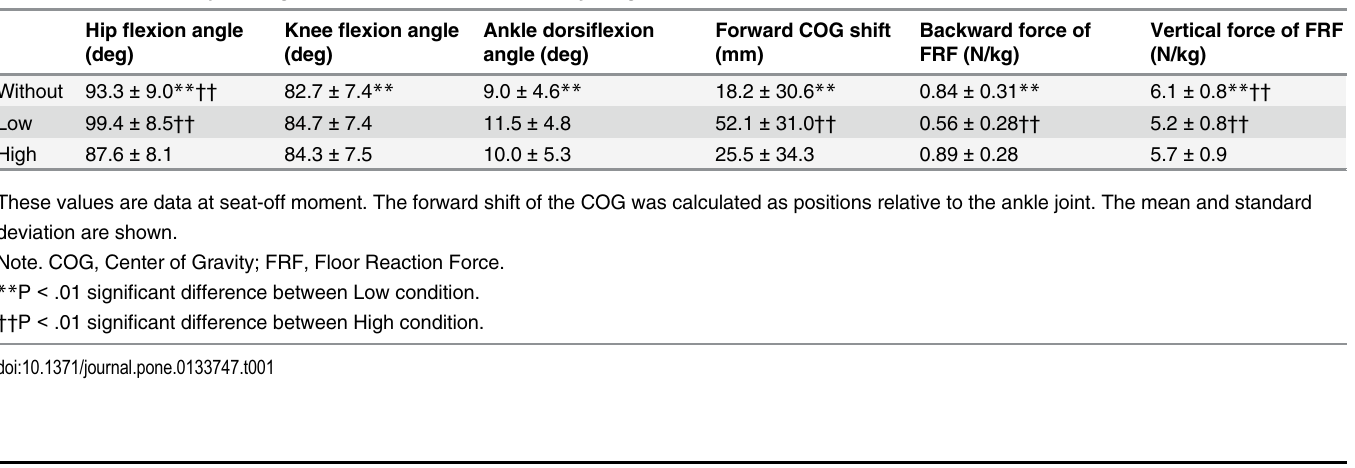
Table 1. Results of the joint angle, shift of the COG, and FRF in young adults. Hip fl exion angle (deg)